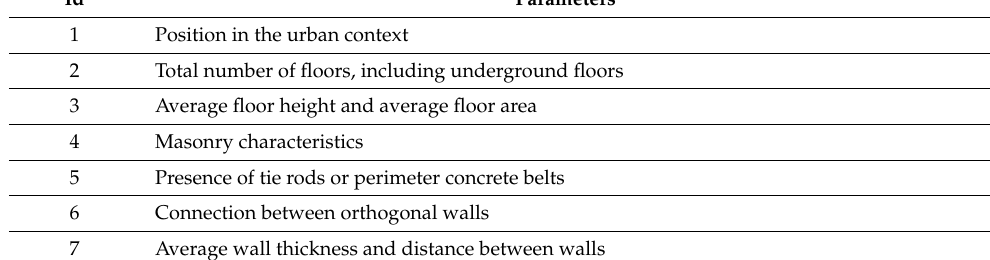
Table 1. Survey form: List of the most common parameters in the analyzed forms.